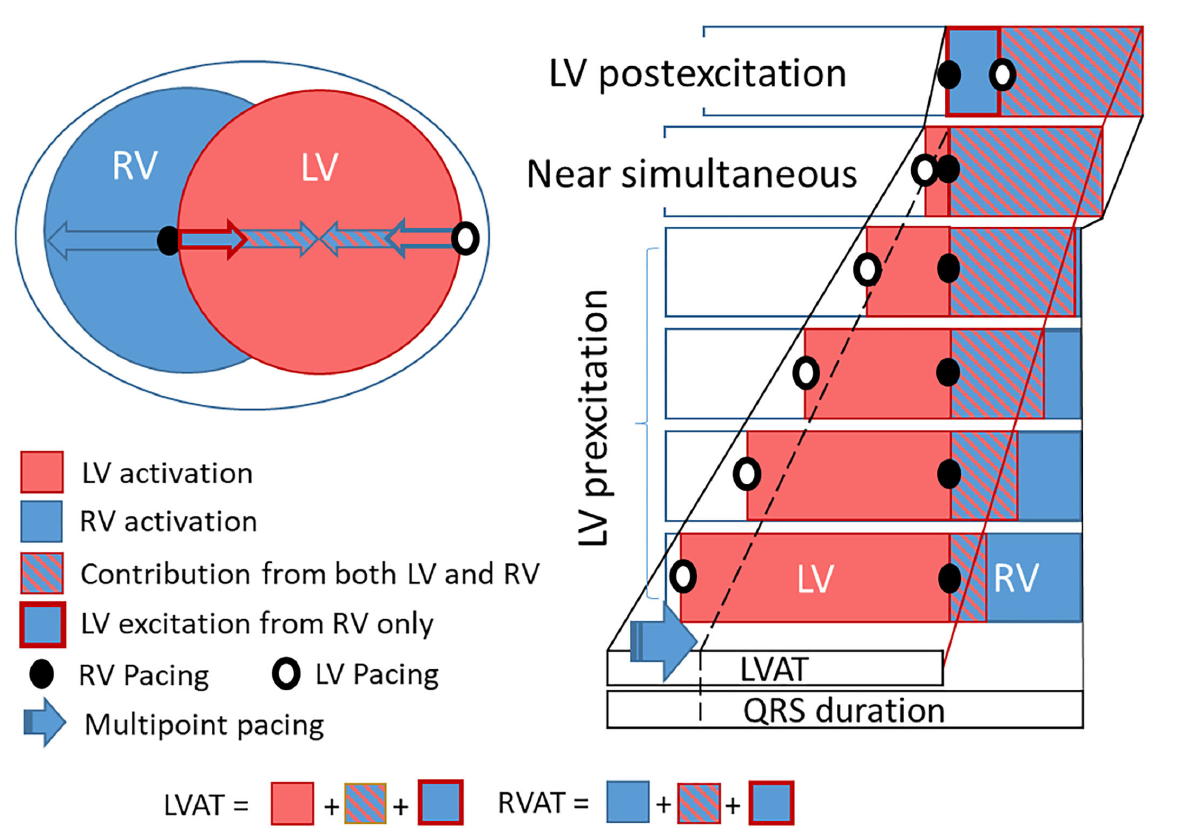
FIGURE5 Diagramatic figure showing an ideal electrical activation diagram with the effect of LV pre-/postexcitation and electrodes on LVAT, RVAT and QRS duration. The diagram shows the theoretical change in LVAT and QRS duration relative to LV pre-/postexcitation based on pacing from the LV electrode, with ideally placed RV and LV electrodes. With near maximal LV pre-excitation, the LV is almost fully activated once RV is paced. The residual area, the area not yet activated from the LV as RV is paced, will be recruited from both the RV paced electrode and the LV paced electrode. Hence recruitment in the area will occur in a shorter time. This effect is more pronounced with less LV pre-excitation up to simultaneous pacing when the effect of combined activation of residual areas reaches its maximum, as the residual area recruited from both LV and RV electrodes is at its largest. LVAT and QRS duration shorten with less LV pre-excitation in this diagram down to simultaneous stimulation. Once the LV is postexcitated, the residual area shrinks and LVAT and QRS duration increase (as long as LVAT > RVAT). Shortening LVAT and QRS duration may also occur from multipoint pacing (MPP) with LV pre-excitation (blue arrow and stippled black line). It is clear from this diagram that the LV electrode position may largely affect LVAT and subsequently QRS duration and that intrinsic RV activation (that may shorten both RVAT and LVAT) will impact how this diagram reads. LV, left ventricle; RV, right ventricle; LVAT, left ventricular activation time; RVAT, right ventricular activation